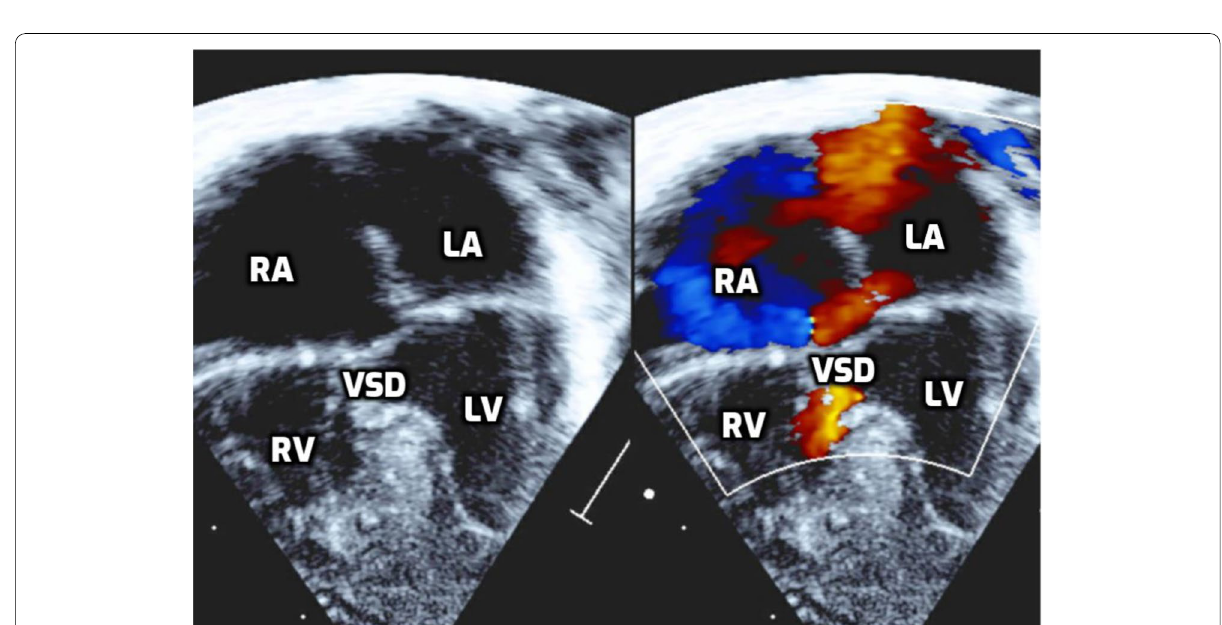
Fig. 1 Preoperative echocardiogram showing complete atrioventricular defect during diastole with large ostium primum shunt. RA RV Right ventricular, LA Left Atrium, LV Left Ventricular = = =